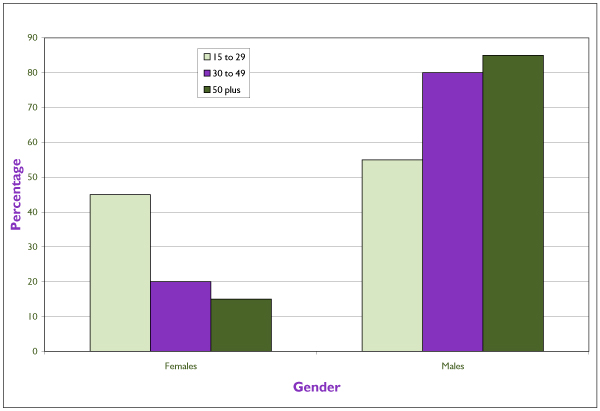
Proportion of Women and Men among Positive HIV Test Reports, by Age Group in 2001 Source: Data from HIV and AIDS in Canada, Surveillance Report to December 31, 2001.